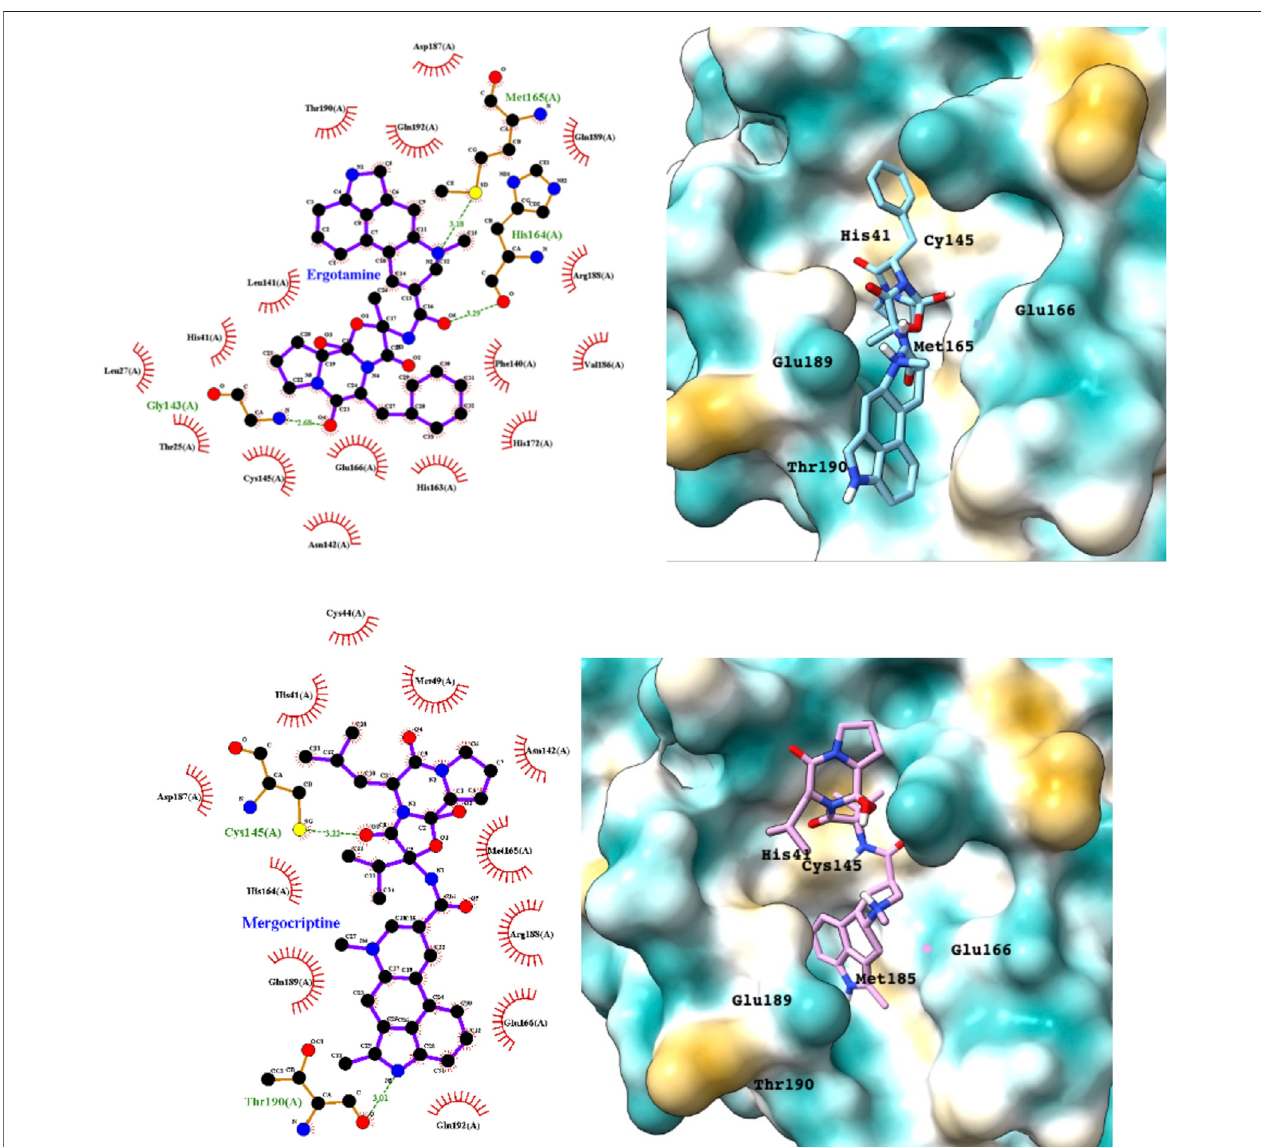
FIGURE 2 | LigPlot (left) and hydrophobic protein surface representation (right) of the main interactions between M pro and ergotamine (top) and mergocriptine (bottom).Themolecular surfacedenoteshydrophobicityofthepockets(bluehydrophilic,yellow/brownhydrophobic).Keybindingsiteresiduesarelabeledtohelporient the